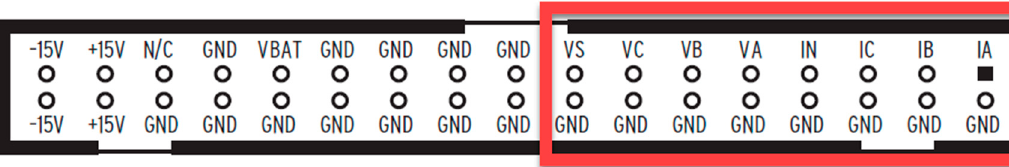
Figure 11. Low–level test interface for SEL–351 relay.